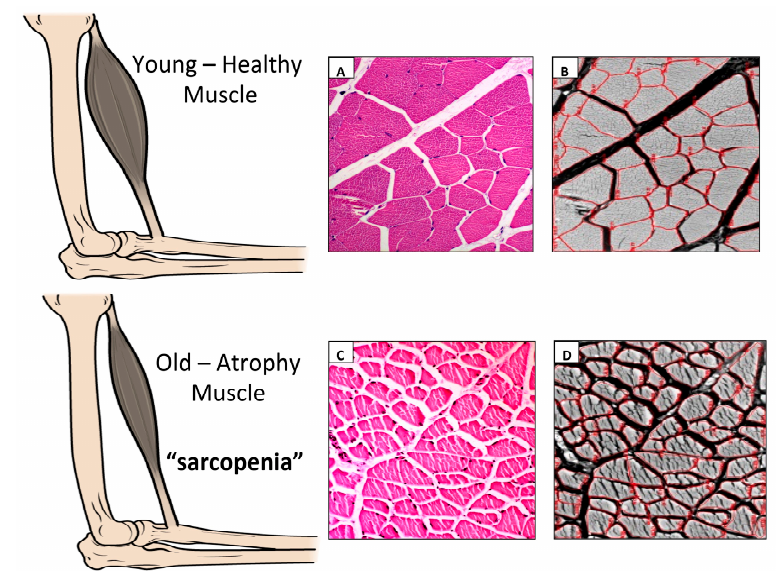
Figure 1. ( A ) Hematoxylin & Eosin staining in order to highlight possible structural alterations in muscle tissue from young, healthy Wistar Rats. Muscle fibers of young healthy rat did not show any damaged histological structure. The samples were examined with a Zeiss Axioplan light microscope (Carl Zeiss, Oberkochen, Germany) and a digital camera (AxioCam MRc5, Carl Zeiss) was used to take the pictures. Lens magnification: 20 × . Scale bars: 50 µ m; ( B ) Morphometric analysis of the perimeter ( µ m) (mean ± SD) of the muscle fibers from young healthy Wistar Rats. In the morphometric analysis of the perimeter ( µ m) (mean ± SD) of the muscle fibers, the young healthy rat shows normal muscle trophic. The perimeter of muscle fibers was considered and calculated using software for image acquisition (AxioVision Release 4.8.2-SP2 Software, Carl Zeiss Microscopy GmbH, Jena, Germany). Lens magnification: 20 × . Scale bars: 50 µ m; ( C ) Hematoxylin & Eosin staining in order to highlight possible structural alterations in muscle tissue from elderly Wistar Rats. Muscle fibers of elderly rat show damaged histological structure as focal perimisio fibrosis. The samples were examined with a Zeiss Axioplan light microscope (Carl Zeiss, Oberkochen, Germany) and a digital camera (AxioCam MRc5, Carl Zeiss) was used to take the pictures. Lens magnification: 20 × . Scale bars: 50 µ m; ( D ) Morphometric analysis of the perimeter ( µ m) (mean ± SD) of the muscle fibers from elderly Wistar Rats. In the morphometric analysis of the perimeter ( µ m) (mean ± SD) of the muscle fibers, the elderly rat shows a highly significant muscle fiber hypotrophy and exhibits remarkable fiber size heterogeneity. The perimeter of muscle fibers was considered and calculated using software for image acquisition (AxioVision Release 4.8.2-SP2 Software, Carl Zeiss Microscopy GmbH, Jena, Germany). Lens magnification: 20 × . Scale bars: 50 µ m.